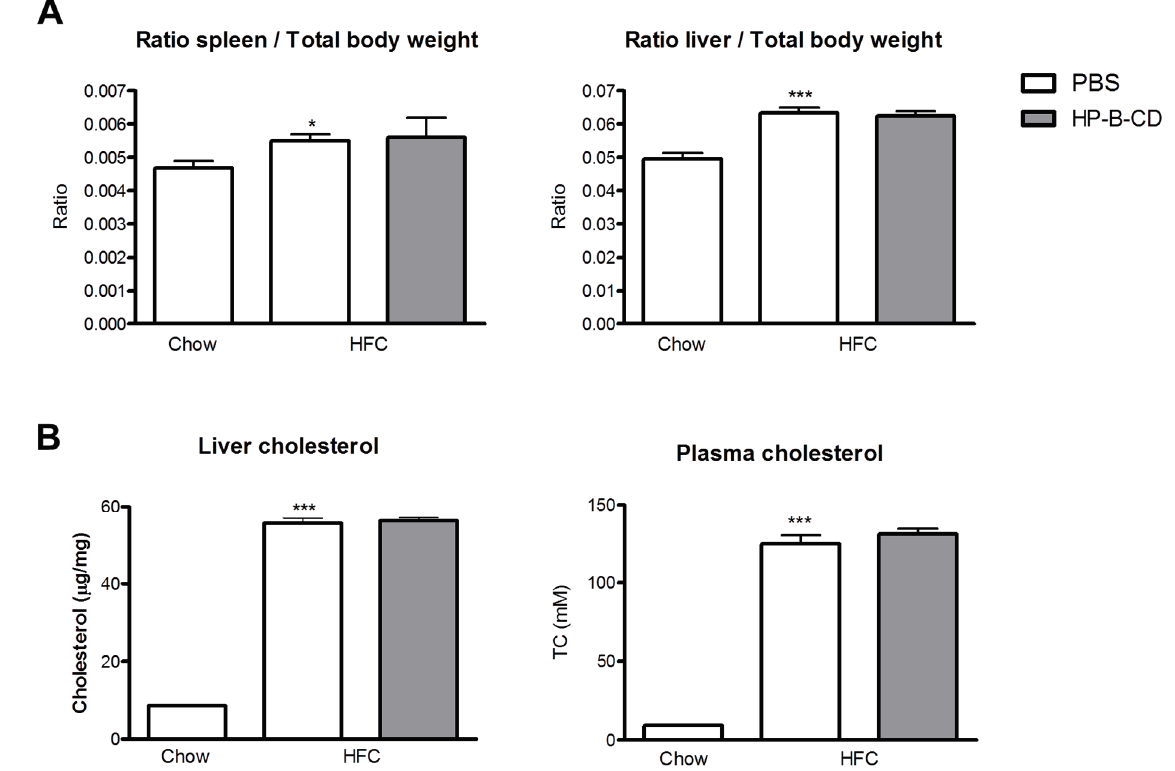
Figure 1. Relative spleen, liver weights and cholesterol levels. ( A ) Relative spleen and liver weights after 12-weeks of regular chow or HFC diet in Ldlr − / − mice with and without HP-B-CD treatment; and ( B ) Cholesterol levels were analyzed in liver as well as plasma of Ldlr − / − mice after 12 weeks of regular chow or HFC diet. TC: total cholesterol. Data are expressed as mean ± SEM ( n = 10 for the chow-fed mice; n = 12 for the mice fed an HFC diet without treatment; n = 12 for the HFC-fed mice receiving HP-B-CD treatment). * Significantly different from chow. * and *** indicate p < 0.05, and 0.001,